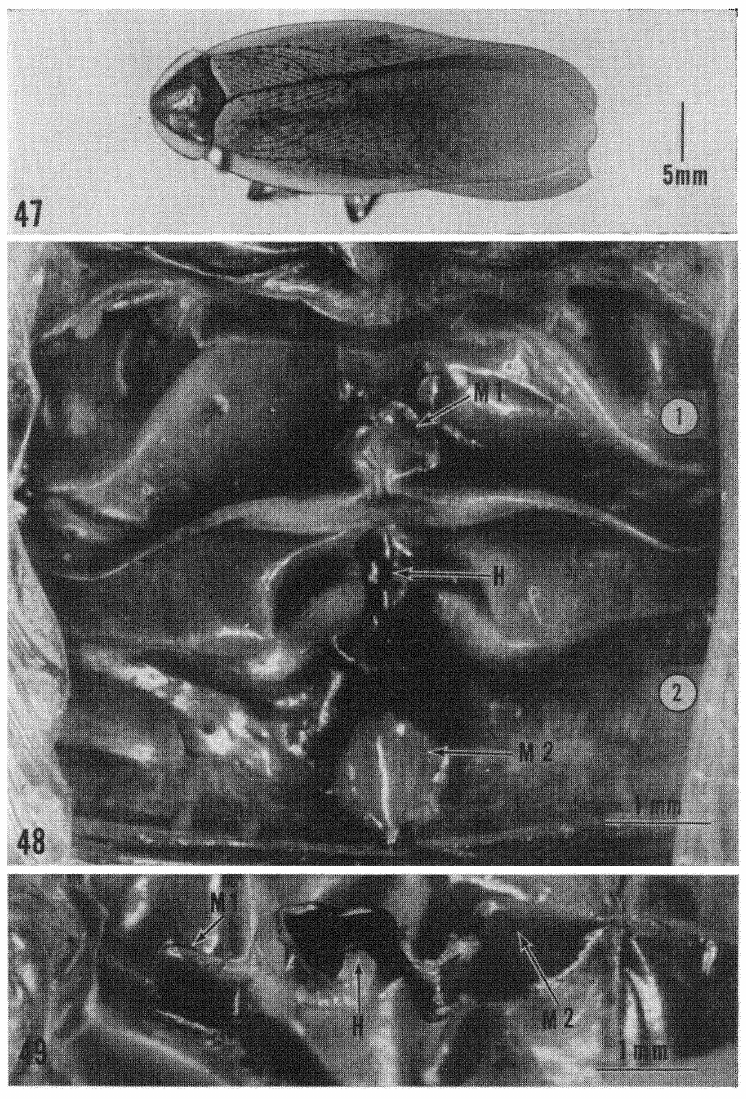
Figs. 47-49. Poeciloderrhis proxima. 47. (22, MCZ). Brazil. (det. Roth). 48-49. (1501, L). Tergal glands on segments and 2 (circled